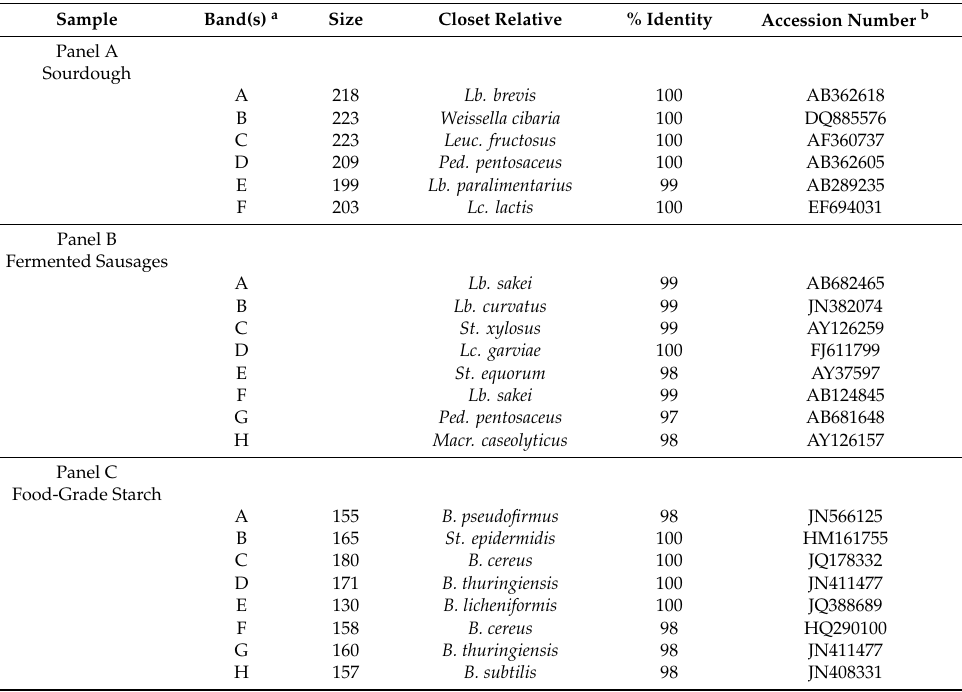
Table 2. Identification of the bands obtained by ePCR and PCR-DGGE of the starch sample. Sample Band(s) a Size Closet Relative % Identity Accession Number b Panel A